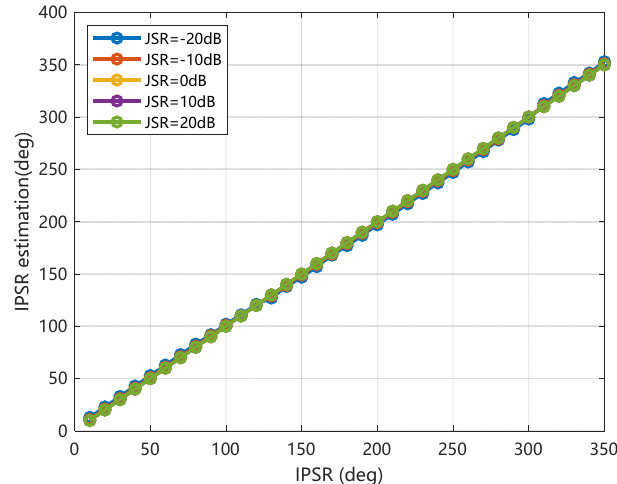
Figure 8. IPSR estimation under different JSRs.